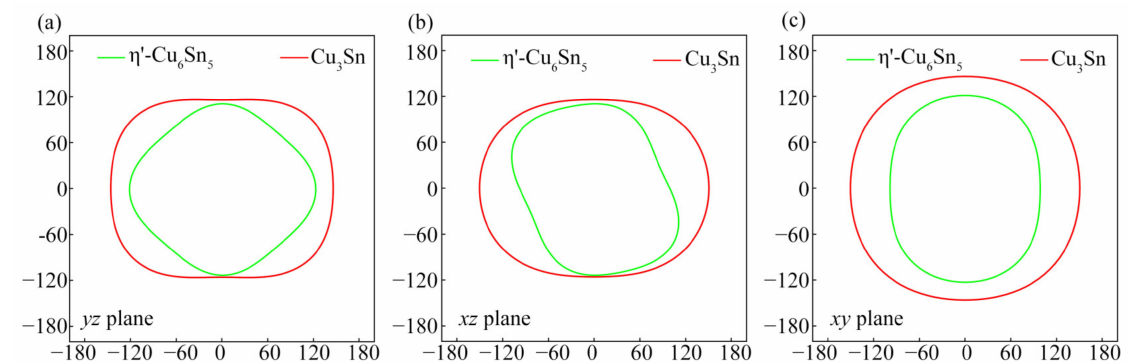
Figure 2. The 3D directional dependence of E for ( a ) η (cid:48) -Cu 6 Sn 5 , ( b ) Cu 3 Sn.